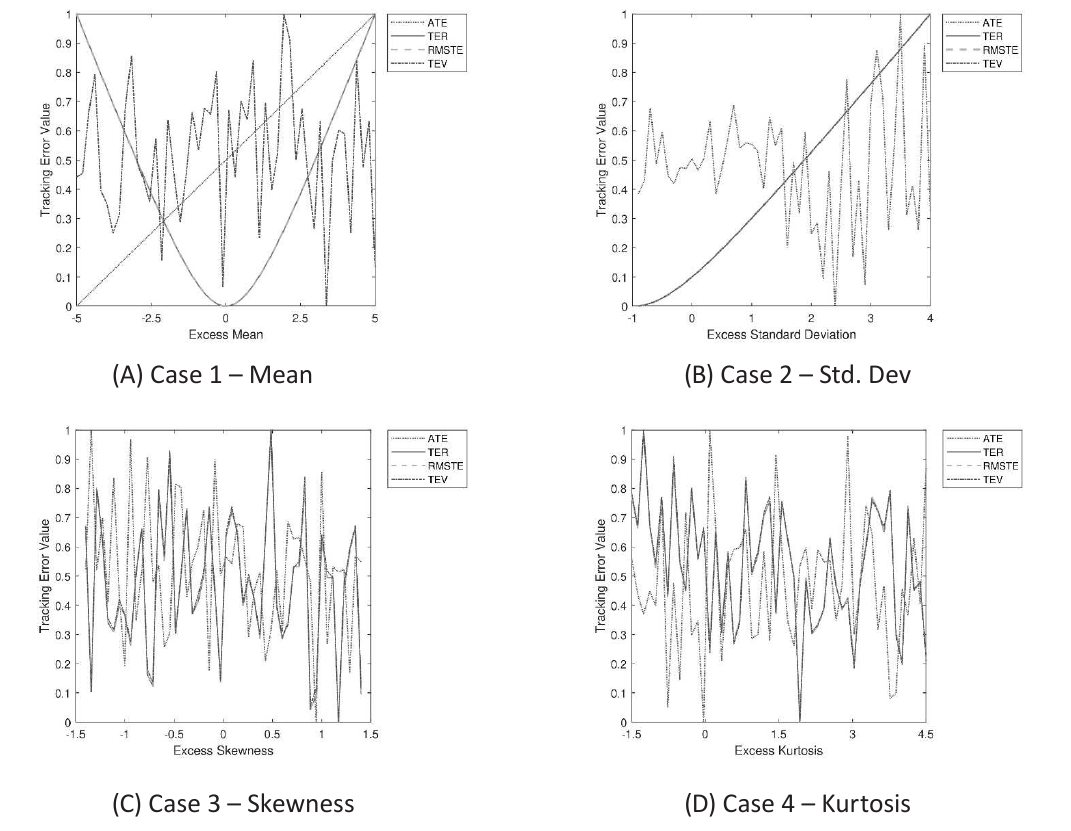
Figure 1. Scaled ATE, TER, RMSTE and TEV